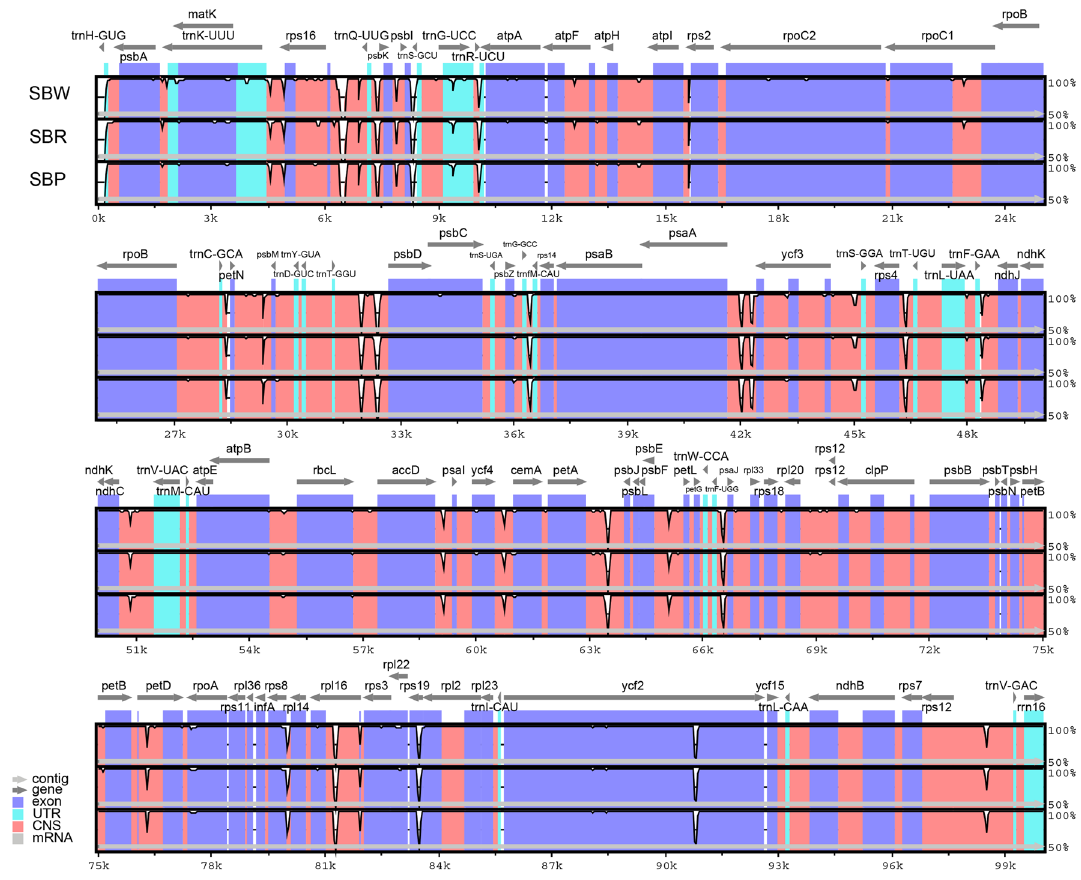
Figure 5. Comparison of three cultivated varieties cp genomes using S. baicalensis (NC027262) annotation as a reference. The vertical scale indicates the percentage of identity, ranging from 50 to 100%. The horizontal axis shows the coordinates within the cp genome. Genome regions are color-coded as exons, introns, and intergenic spacer (IGS), and the Gray arrows indicate the direction of transcription of each gene. Annotated genes are displayed along the